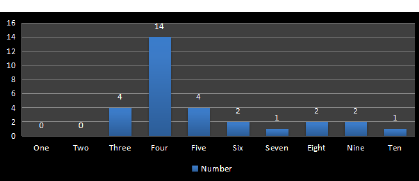
Figure 12. Distribution of study subjects according to radiological union time (months)